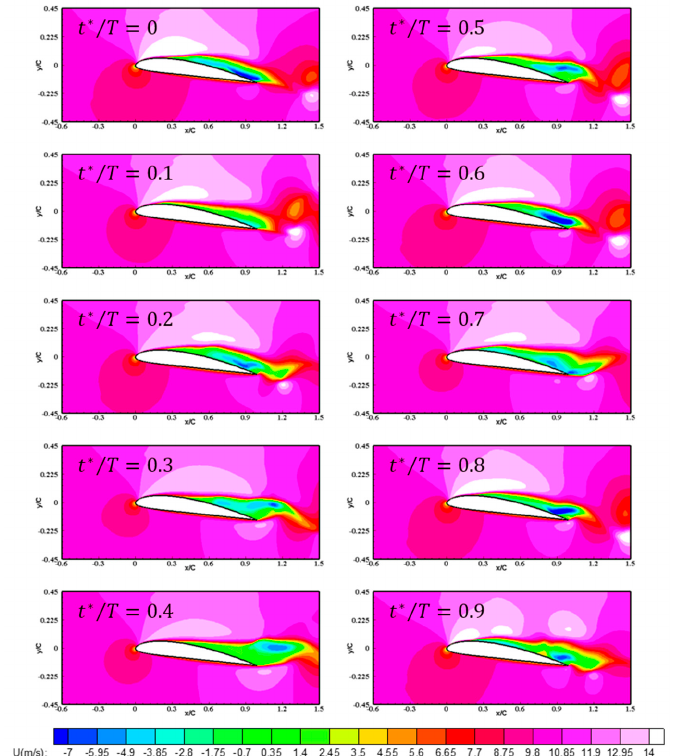
Figure 14. Time-variation of predicted x-directional velocity: thin-layer case.